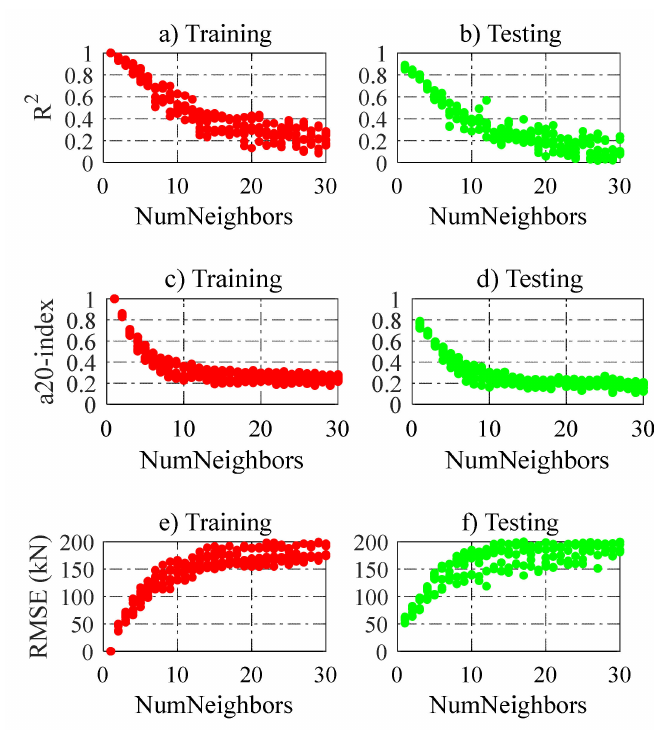
Figure 6. The performance of 210 KNNs models.